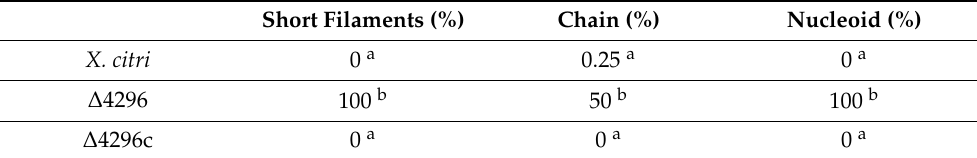
Table 3. Statistics of morphotypes and nucleoid distribution of cells cultivated in rich medium (NB) and ampicillin. Short Filaments (%) Chain